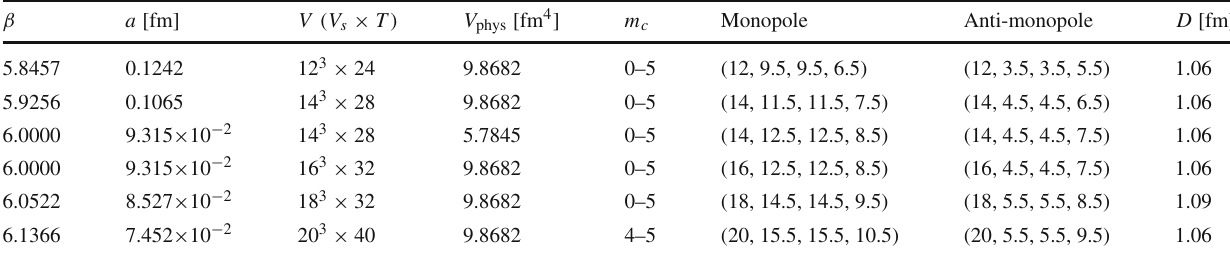
, x , y , z ) in the lattice a a a a